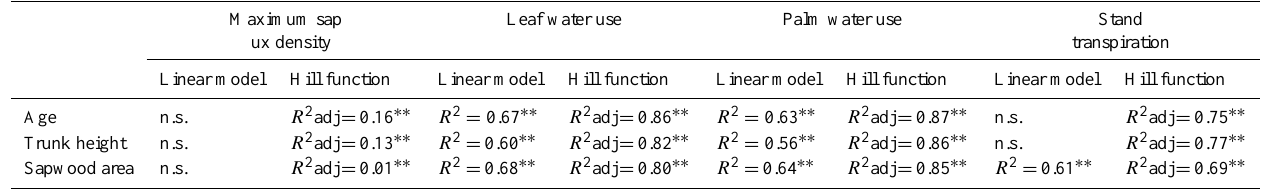
Table 3. Summary table of results for 12 oil palm stands, i.e., excluding three stands of yet unexplained much higher water use (PTPN6, BO5, and HO2). R 2 and P values for linear regression and fitting a Hill function, respectively, are presented to explain variability in water use characteristics (i.e., maximum sap flux density, leaf water use, palm water use and stand transpiration) by the stand variables age, trunk height and sapwood